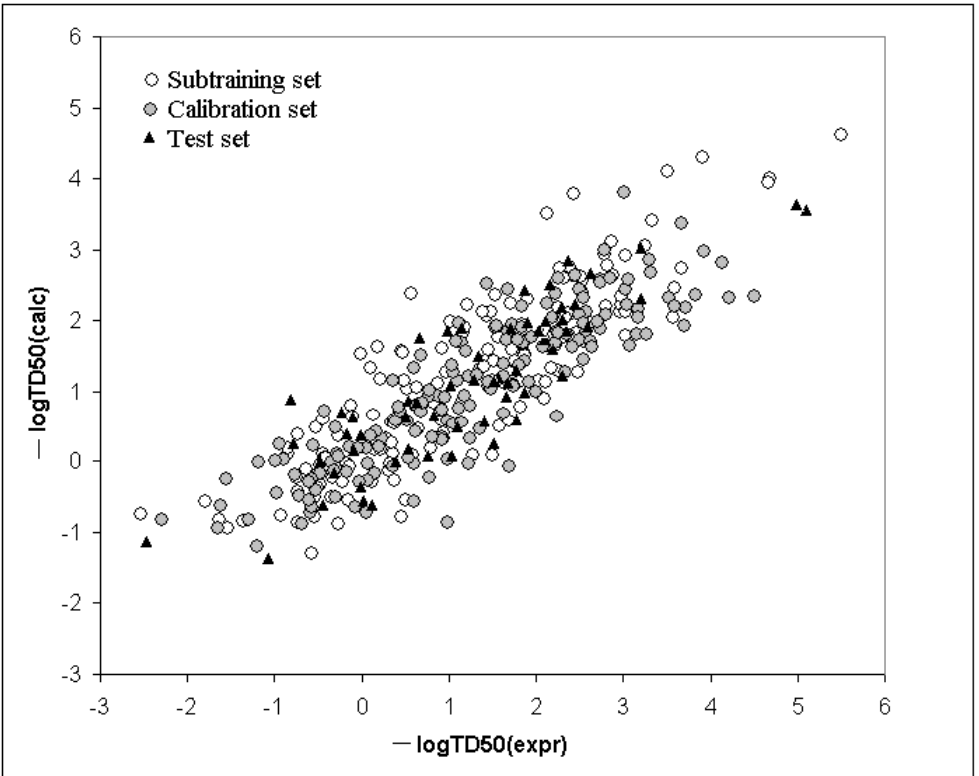
calculated with Equation 50